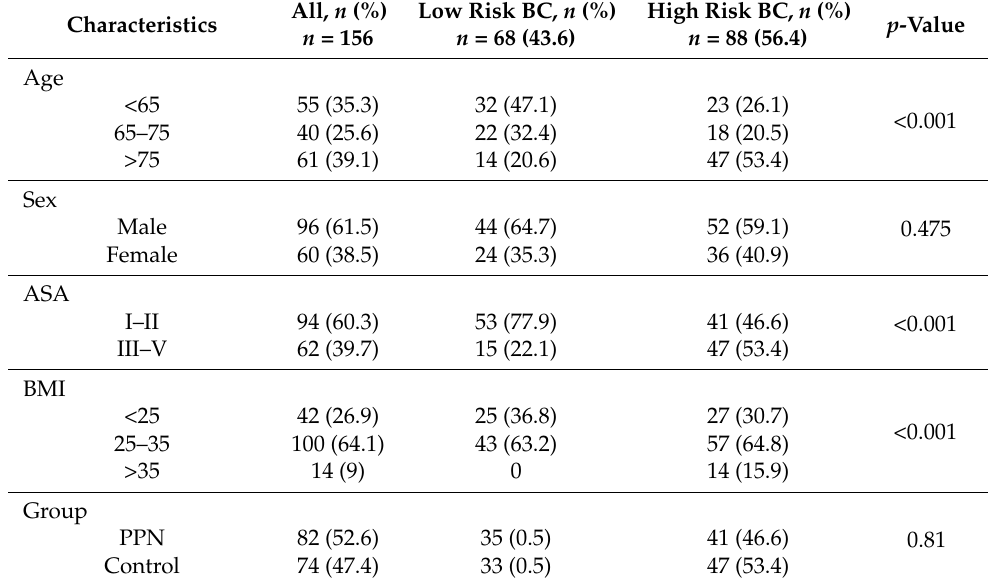
Table 2. The relationship between clinicopathological characteristics and clinical outcomes stratified by low- or high-risk body composition in the BCE